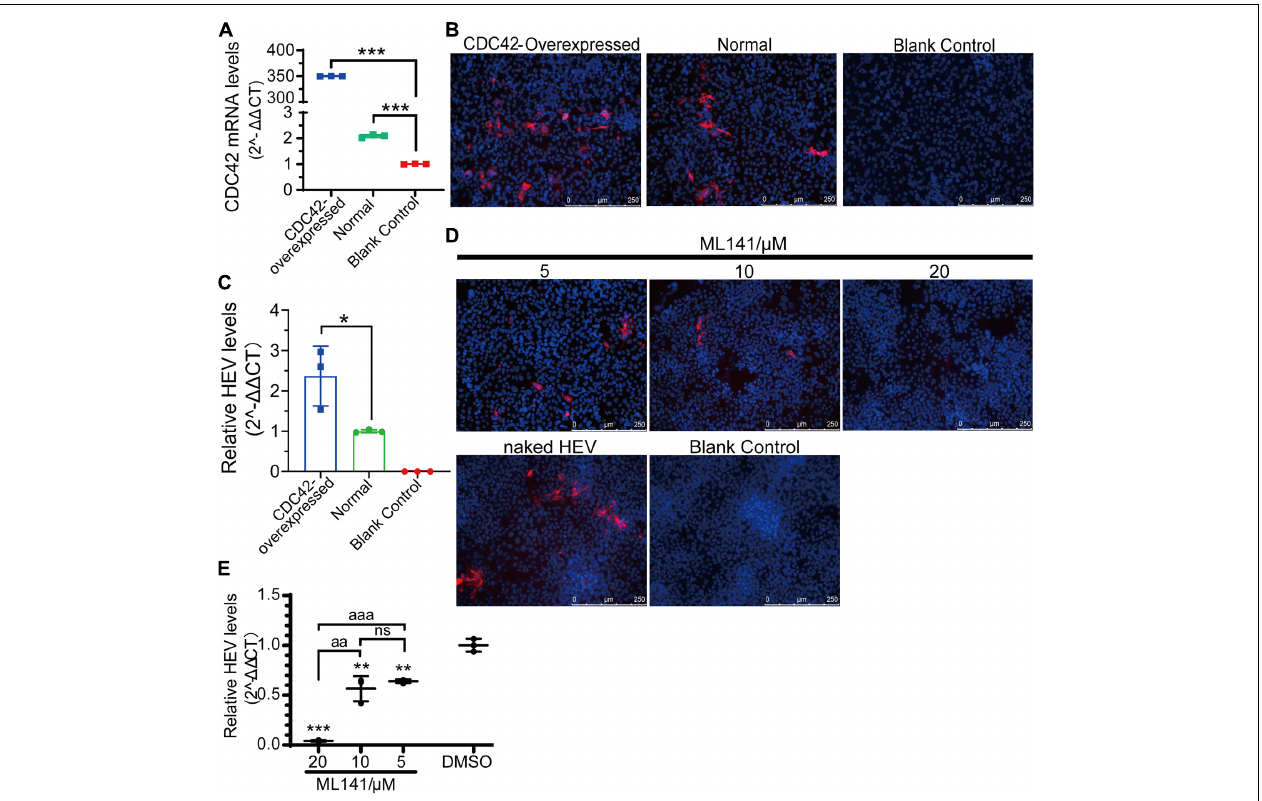
FIGURE 7 | Positive correlation between expression level and activity of CDC42 and naked HEV-3 infection in HepG2/C3A cells. (A) Relative CDC42 mRNA levels in HEV-infected HepG2/C3A cells with different pretreatment. Increasing of HEV-3 infection in the CDC42-overexpressed HepG2/C3A cells by IFA (B) and qPCR detection (C) . IFA (D) and qPCR (E) detect non-enveloped HEV-3 in ML141-pretreated HepG2/C3A cells. The result of the qPCR assay was normalized to human GAPDH. ns, no significant; *, P < 0.05; ** and aa, P < 0.01; *** and aaa, P <